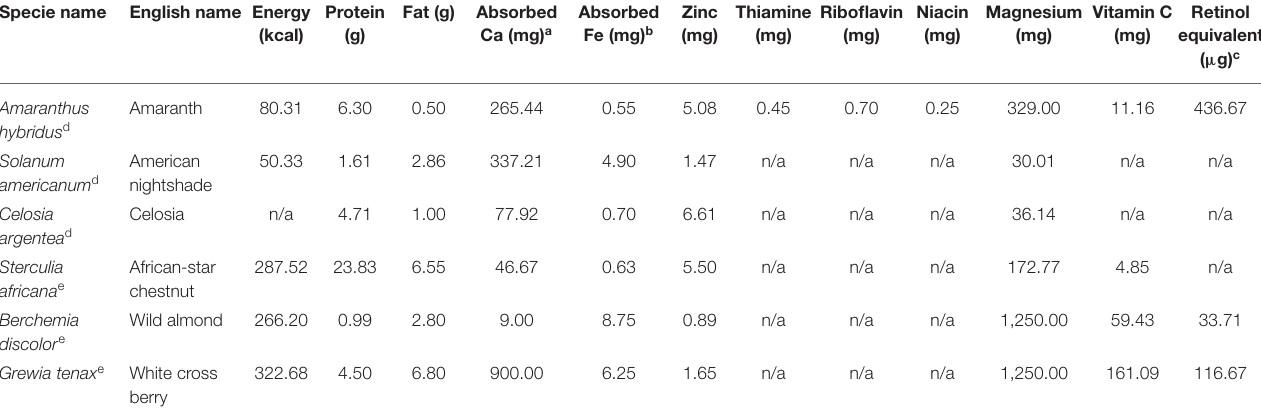
TABLE 1 | Nutrient composition per 100g of edible portion of six wild plant foods from the local agrobiodiversity in Turkana selected for inclusion in the models.